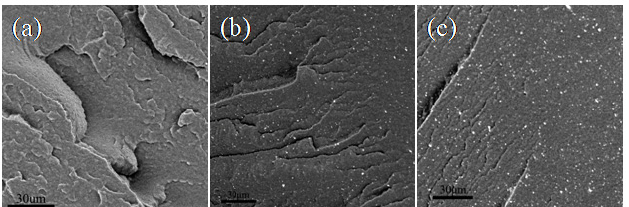
Figure 6. SEM of sections of non-semiconducting shielding materials with different LSC contents: ( a ) 0 wt% LSC; ( b ) 1 wt% LSC; ( c ) 5 wt% LSC.